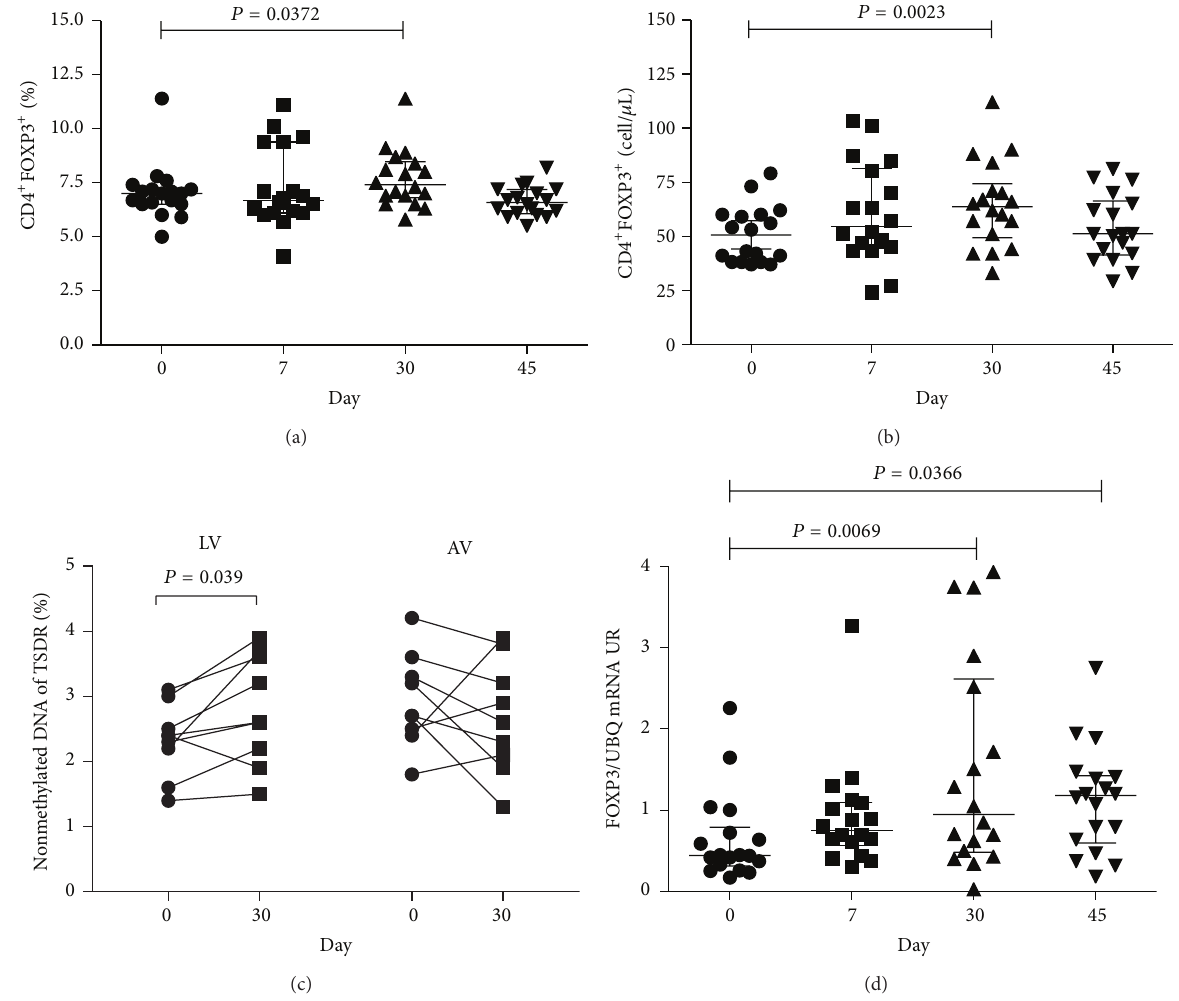
Figure 1: Statins increase the frequency of CD4 + FOXP3 + Treg and mRNA FOXP3. The frequency (a) and absolute number (b) of CD4 + FOXP3 + cells were evaluated by flow cytometry. Methylation percentage in the Treg cell-specific-demethylated-region (TSDR) of FOXP3 gene,inDNAofPBMCfromindividualsbeforetreatmentand30daysafterongoingtreatment,isshown(c).FOXP3mRNAexpression relative to UBC housekeeping gene (d). Median, interquartile range (IQR), and 𝑃 values are shown in the graph; difference between days was tested by Wilcoxon signed-rank